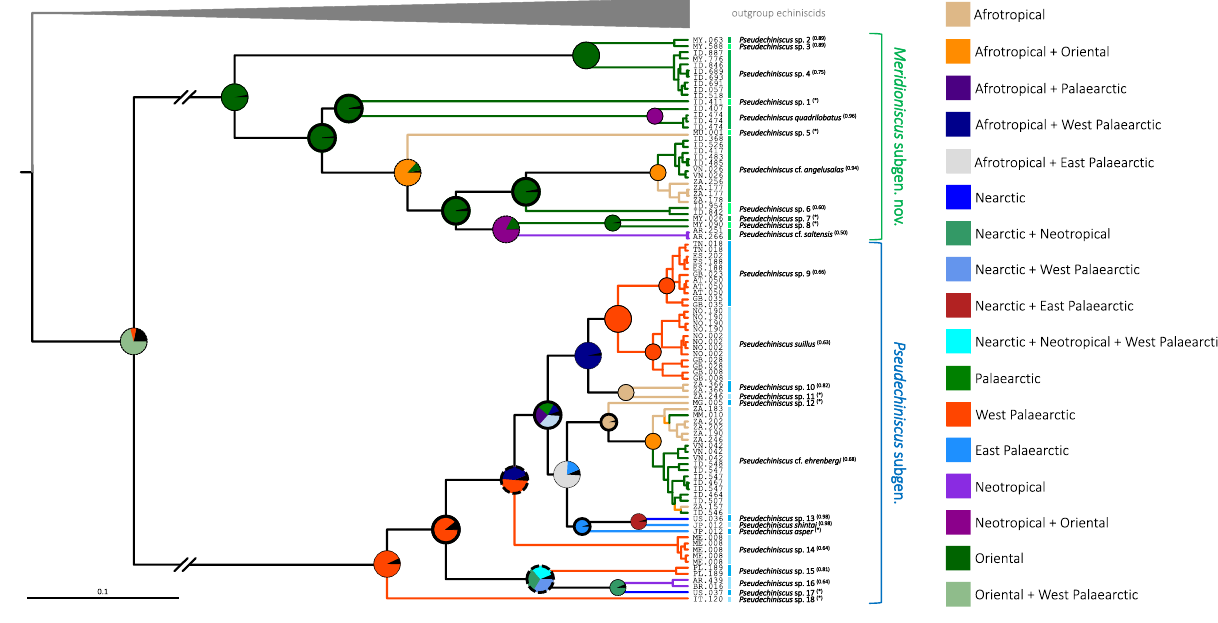
Figure 7. Historical biogeography of Pseudechiniscus reconstructed using BioGeoBEARS under the DIVALIKE model. Nodal pie charts show the relative probability of historical geographic ranges according to the in-figure colour legend. Pie charts with bolded margins denote points of dispersal, whereas these with discontinuous margins indicate a vicariant origin. Black colour signifies unexplained